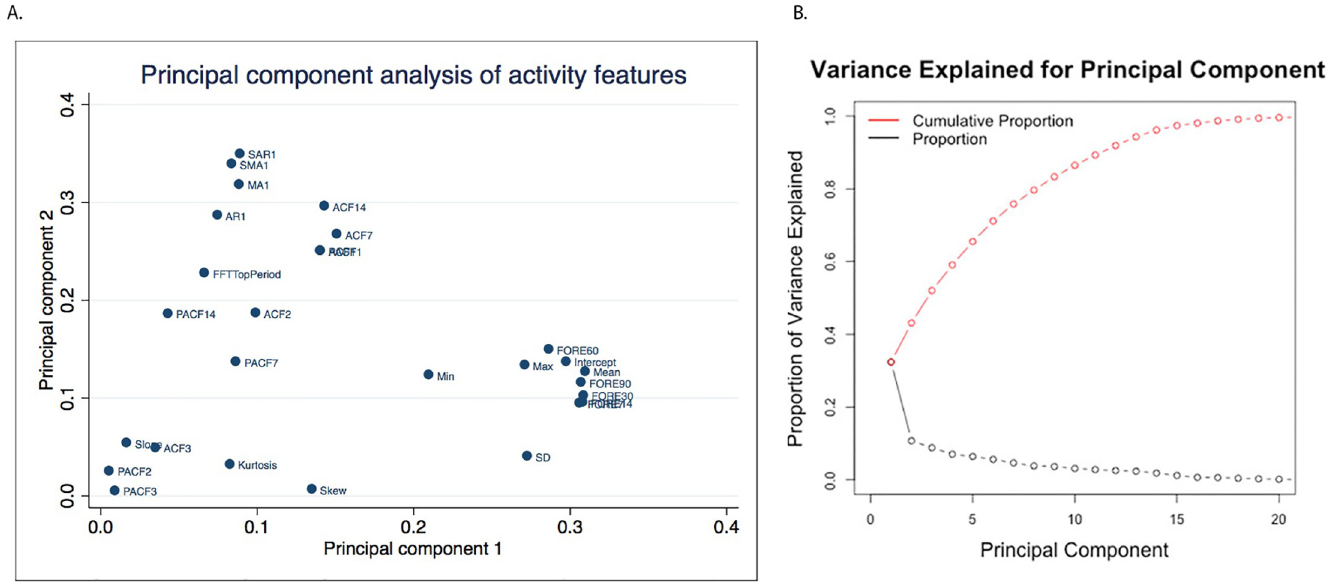
Fig 1. A. First two principal components of activity features. B. Cumulative variance explained by principal components.